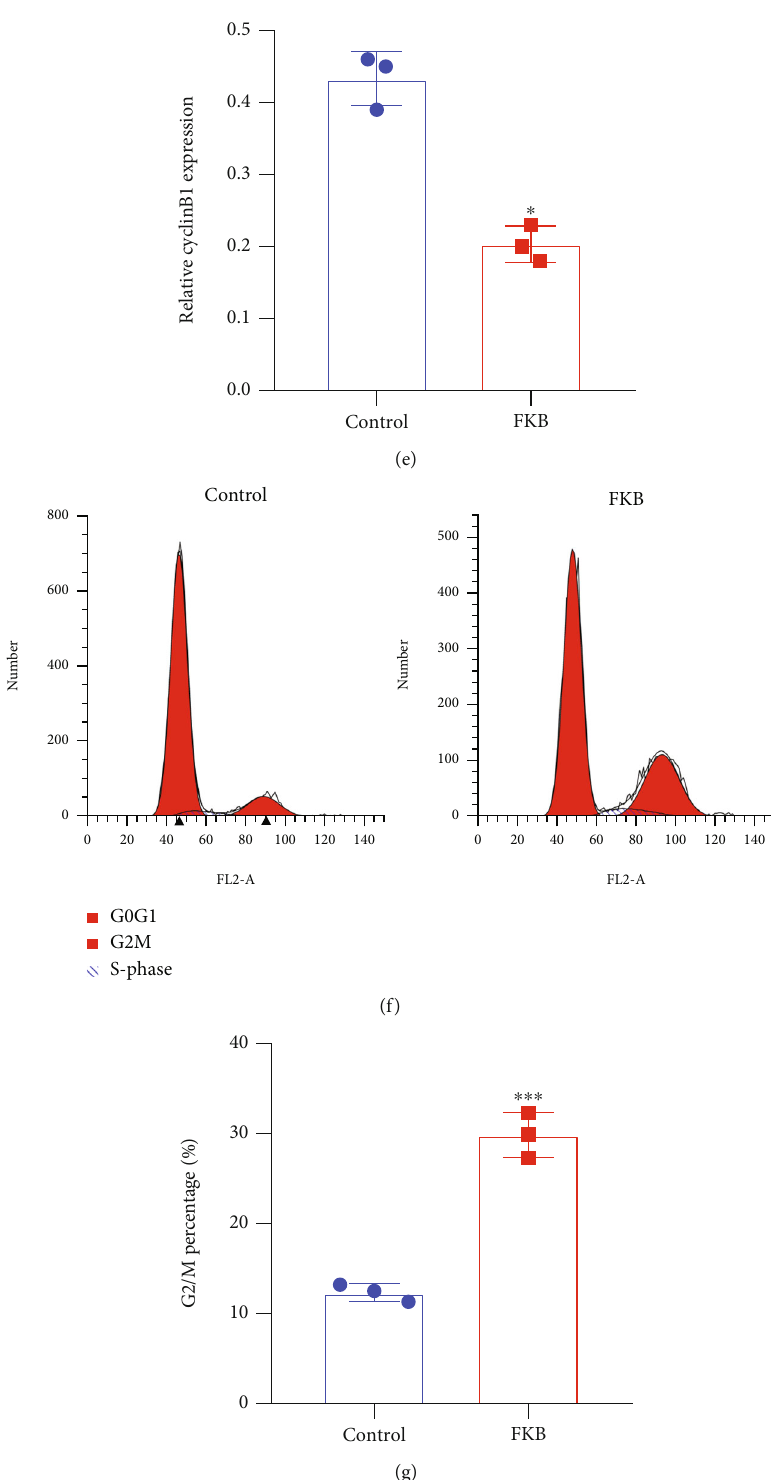
Figure 2: FKB downregulates the expression of cell cycle-related proteins in gastric cancer cells. (a) Representative images of western blots. (b) Cdc2, (c) Cdc25C, (d) cyclin A, and (e) cyclin B1 expression was quanti fi ed in SGC-7901 cells of the two groups. (f, g) The fl ow cytometry analysis of the cell cycle in SGC-7901 cells of the two groups. ∗ p < 0 : 05 ; ∗∗ p < 0 : 01 ; ∗∗∗ p < 0 : 001